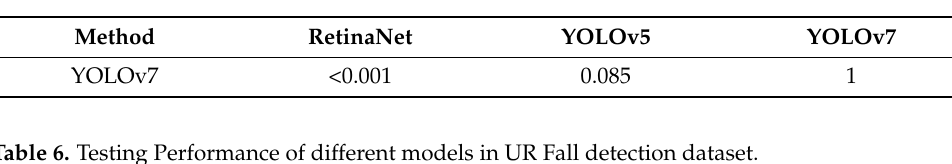
Table 5. p -Values of the McNemar’s significance test on UR-Fall dataset.